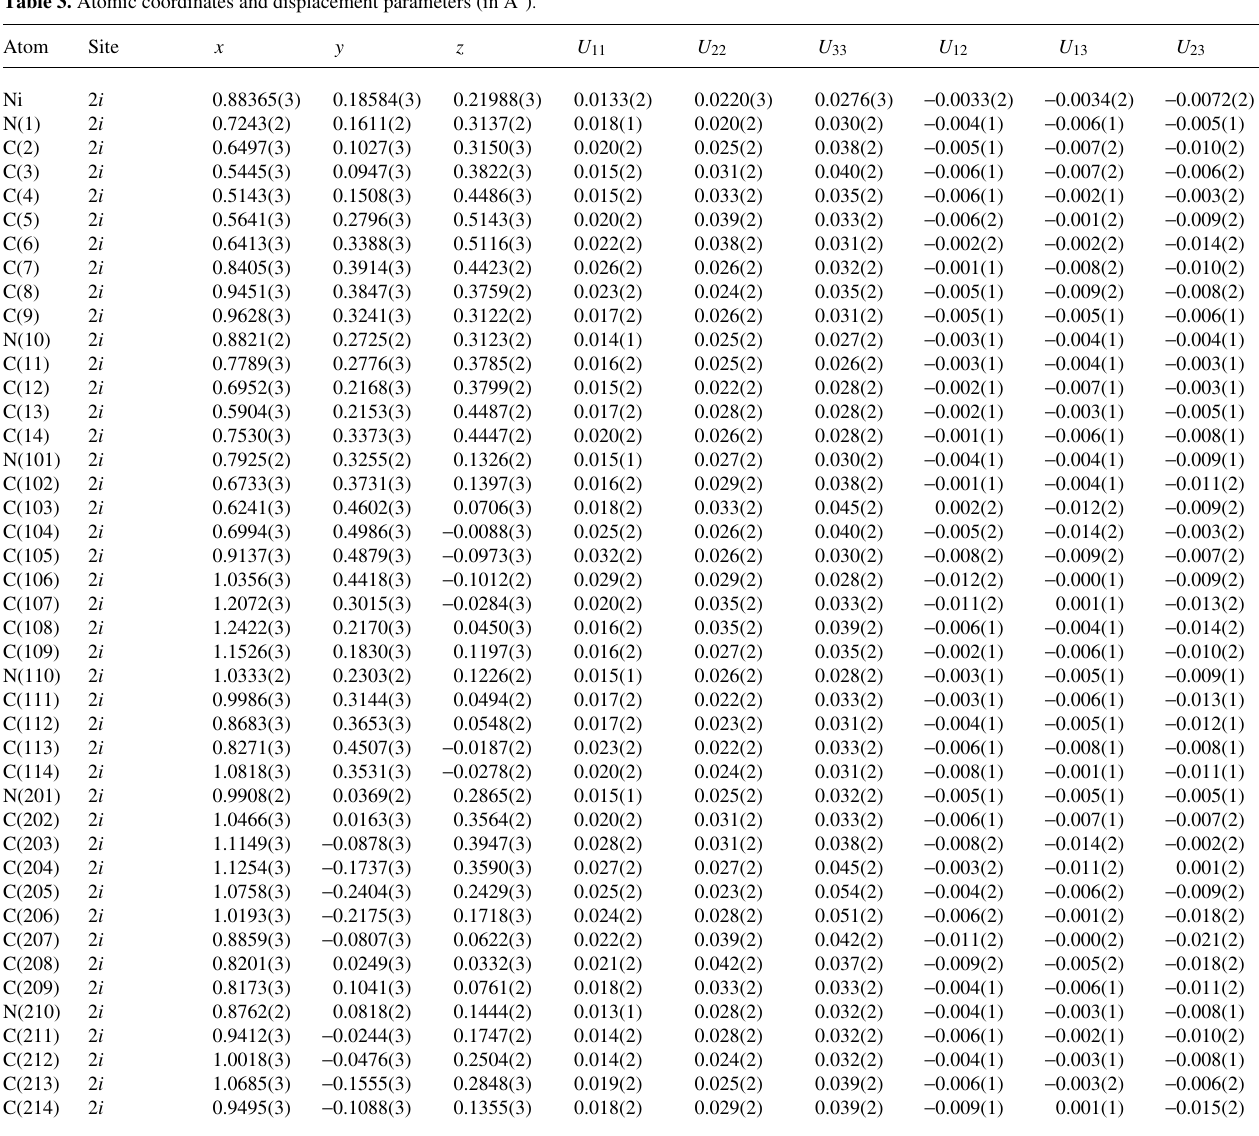
Table 3. Atomic coordinates and displacement parameters (in Å 2 )